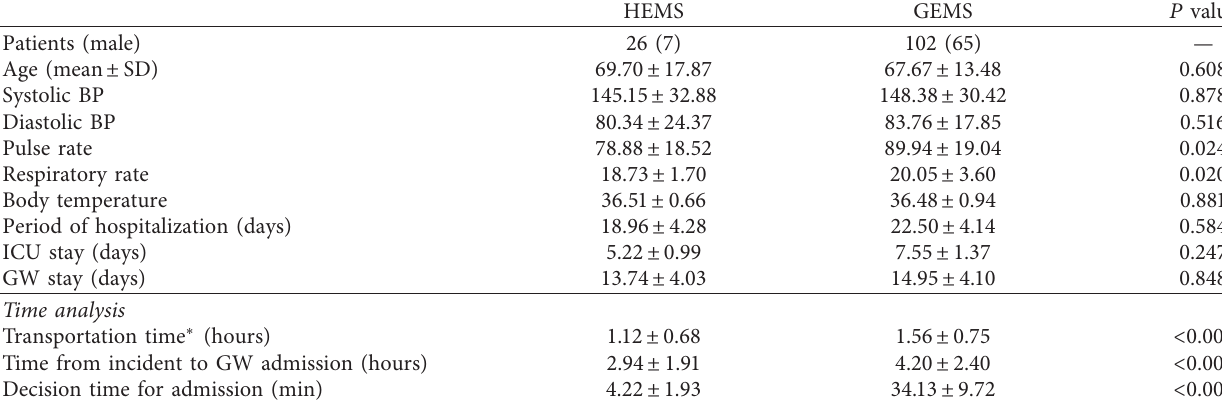
Table 1: Characteristics of patients assisted via HEMS or